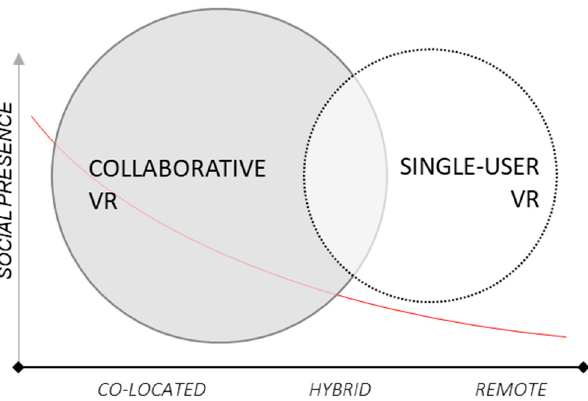
Figure 2. VR choices across different modes of working and the extent of social presence achieved.